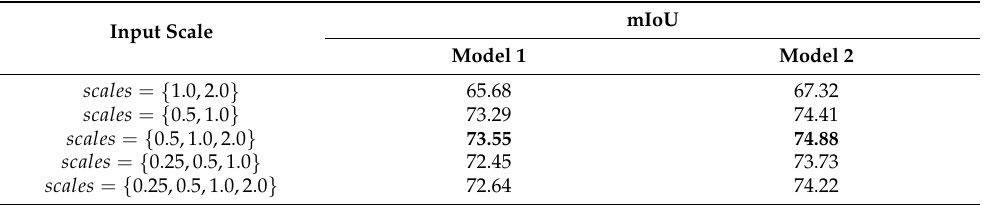
Table 5. The mIoU values obtained by Model 1 and Model 2 with the five kinds of multiscale inputs. Input Scale